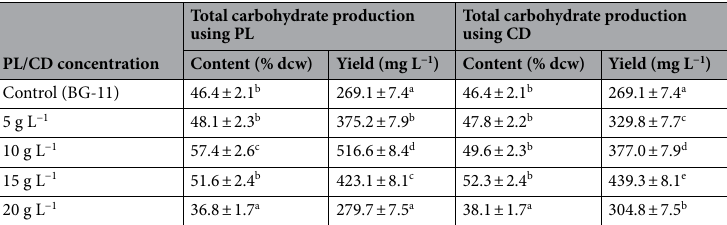
Table 3. Maximum total carbohydrate production of A. variabilis cultivated in different concentrations of PL and CD, compared to control BG-11 medium. Values were calculated as the mean (± SE) of three independent observations, i.e., n = 3. Significant differences among the values (P < 0.05, DMRT) within a column are designated using different alphabetic annotations.